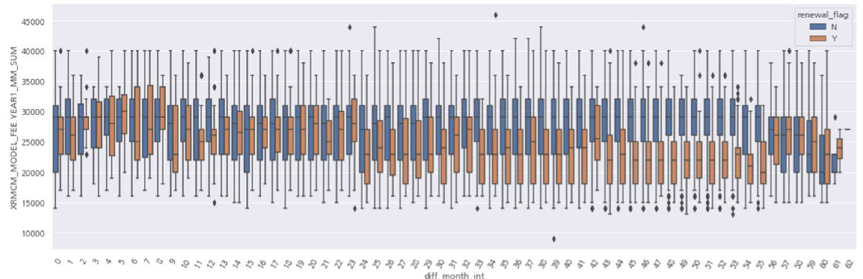
Fig. 8 Results of comparative analysis by renewal (Y/N)—Monthly fee for the first year according to the number of months of